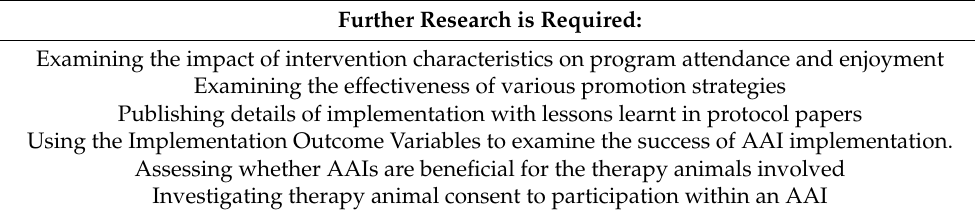
Table 6. summary of